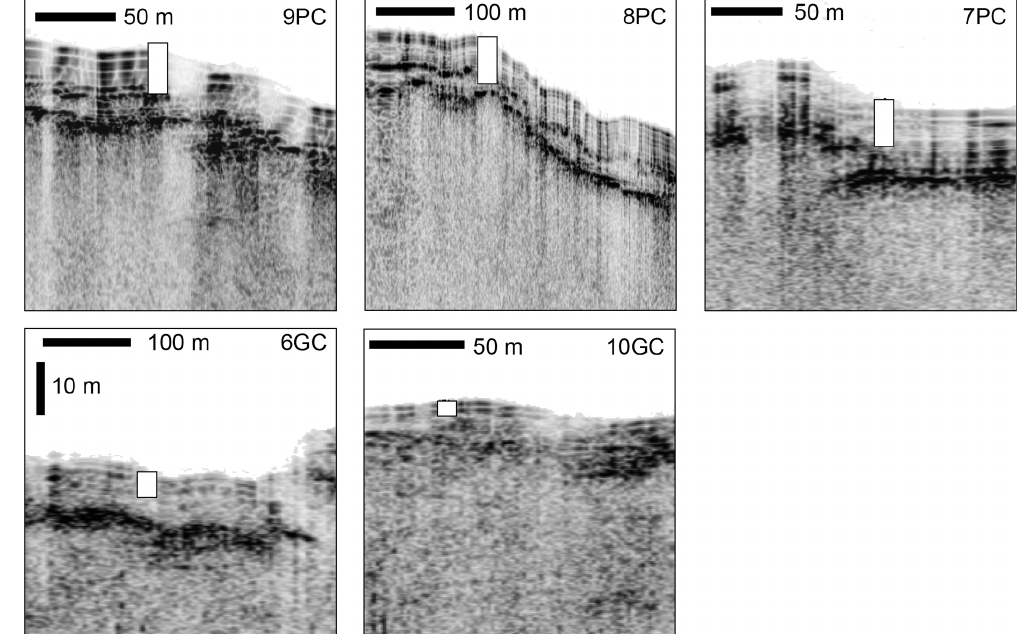
Figure 4. Sub-bottom profiles across coring stations in Sherard Osborn Fjord illustrating the amount of the sedimentary cover on top of acoustic basement penetrated by each